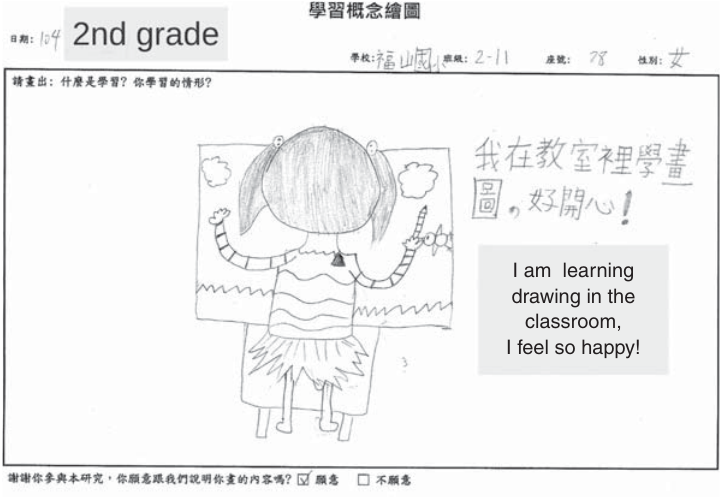
Figure 11. A drawing by a 2nd